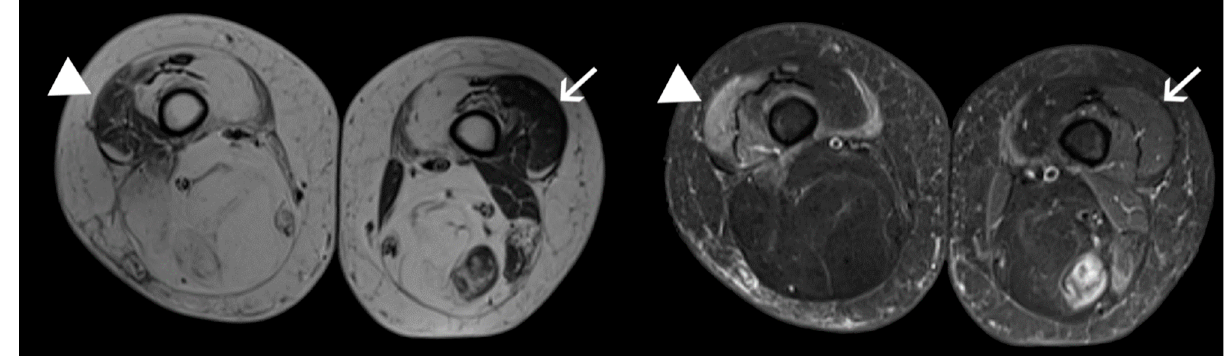
Figure 2. Muscles sampled by microdialyisis. STIR+ (arrowhead) and STIR- (arrow) vastus lateralis muscles sampled in the same patient. Axial STIR sequences of the thigh muscles are shown on the right-hand side, with corresponding T1-weighted images on the left. Table 1. Summary of the characteristics of study participants. Age is reported as mean ± standard deviation; for EcoRI fragment length (in kb) and Clinical Severity Scale (CSS) the median value is indicated. M = males, F = females. CATEGORY